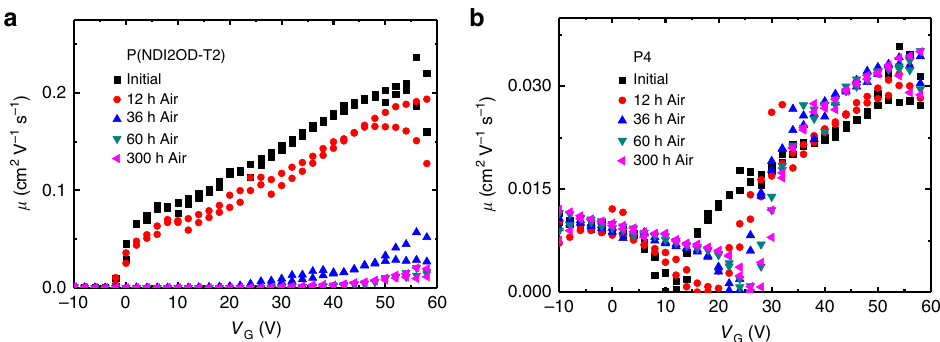
Fig. 5 Transistor properties of P4 and N2200. Transistor transfer curves of ( a ) p(NDI2OD-T2) 41 (N2200) and ( b ) P4 highlighting the air stability of n-charge transport of P4 in comparison to the state of the art p(NDI2OD-T2)